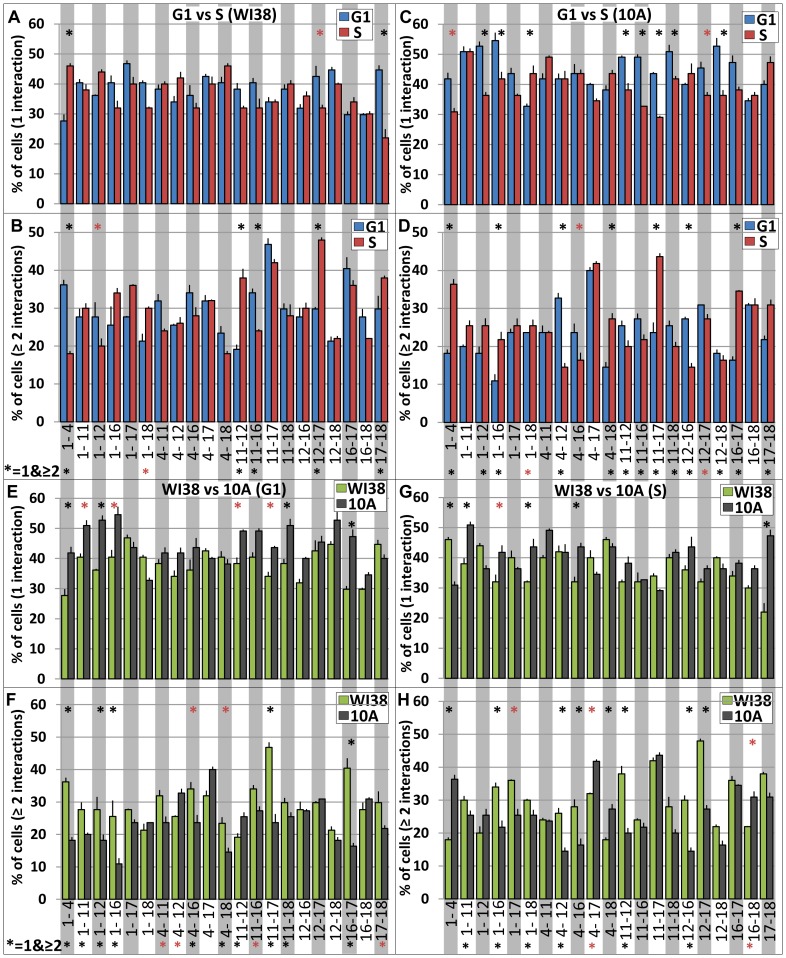
Interaction profiles of CT are altered across the cell cycle and cell types.Since each CT has two homologs there are four possible interactions in each nucleus. (A–D) Differences across the cell cycle- The percent of cells with only 1 interaction (A) and the percent of cells that have 2 or more interactions (B) in WI38 are shown for each of the 21 pairwise combinations of CT (G1, n = 46; S, n = 47). The percentage with only 1 (C) and 2 or more (D) in 10A are shown (G1, n = 56; S, n = 54); blue bars are G1 and red are S. (E–H) differences between cell types- The percent of cells with only 1 interaction (E) and the percent of cells that have 2 or more interactions (F) in G1 of WI38 and 10A are shown. The percent with only 1 (G) and 2 or more (H) in S of WI38 and 10A are shown, green bars are WI38 and black are 10A. error bars = SEM. Black asterisks indicate chi-square test, p<0.05, while red indicate p<0.10. Full p values are presented in Tables S3,S6.